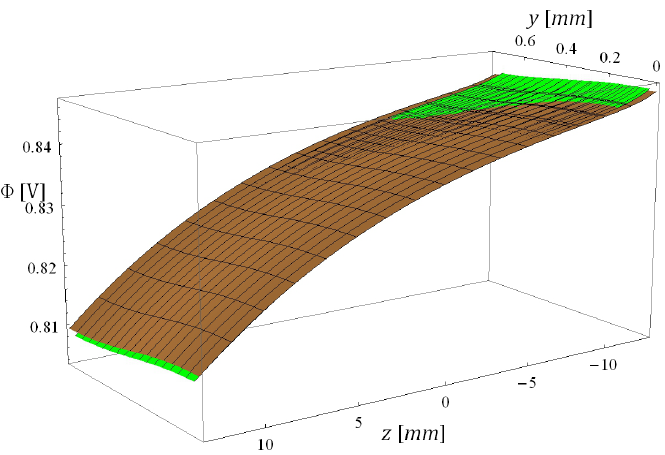
Figure 11. Cathode Galvani potential distribution at 0.75 V of operational voltage. Green plot are CFD results and brown HAN-FC results.